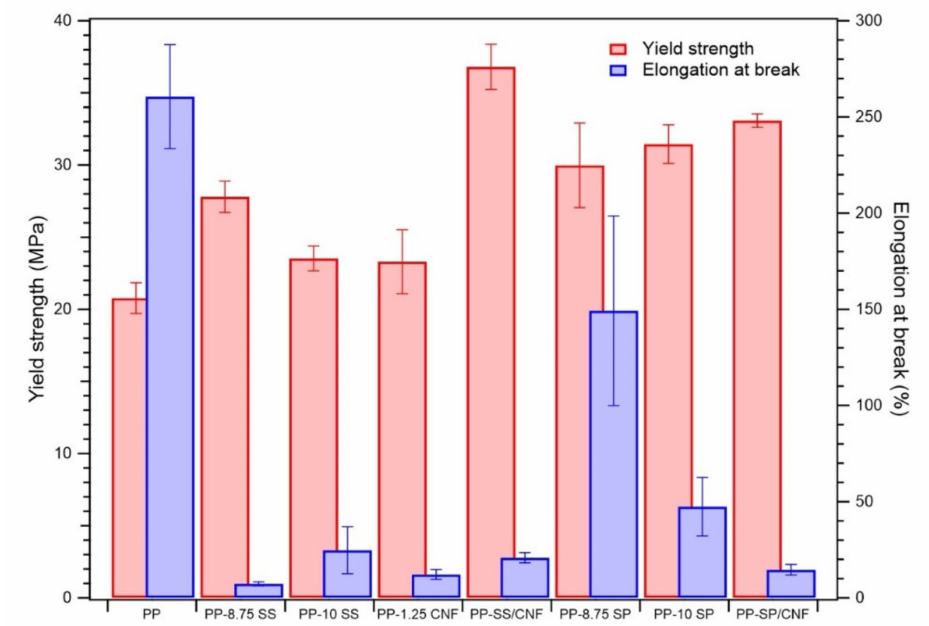
Figure 8. Mechanical properties of PP composites: bar charts of elongation at break and yield